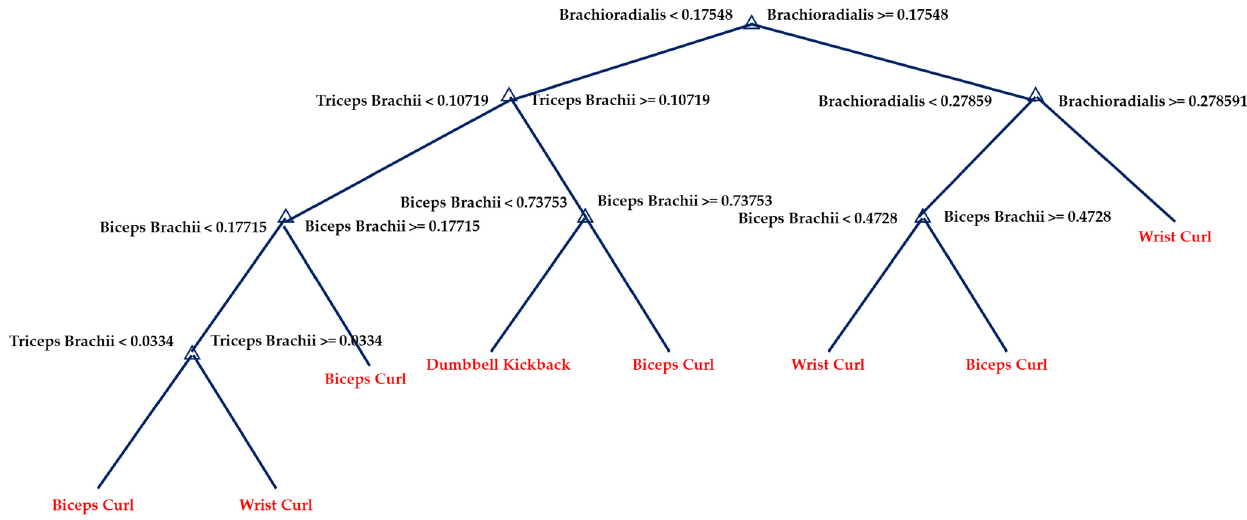
Figure 14. The graphical display of one tree in the DT model.